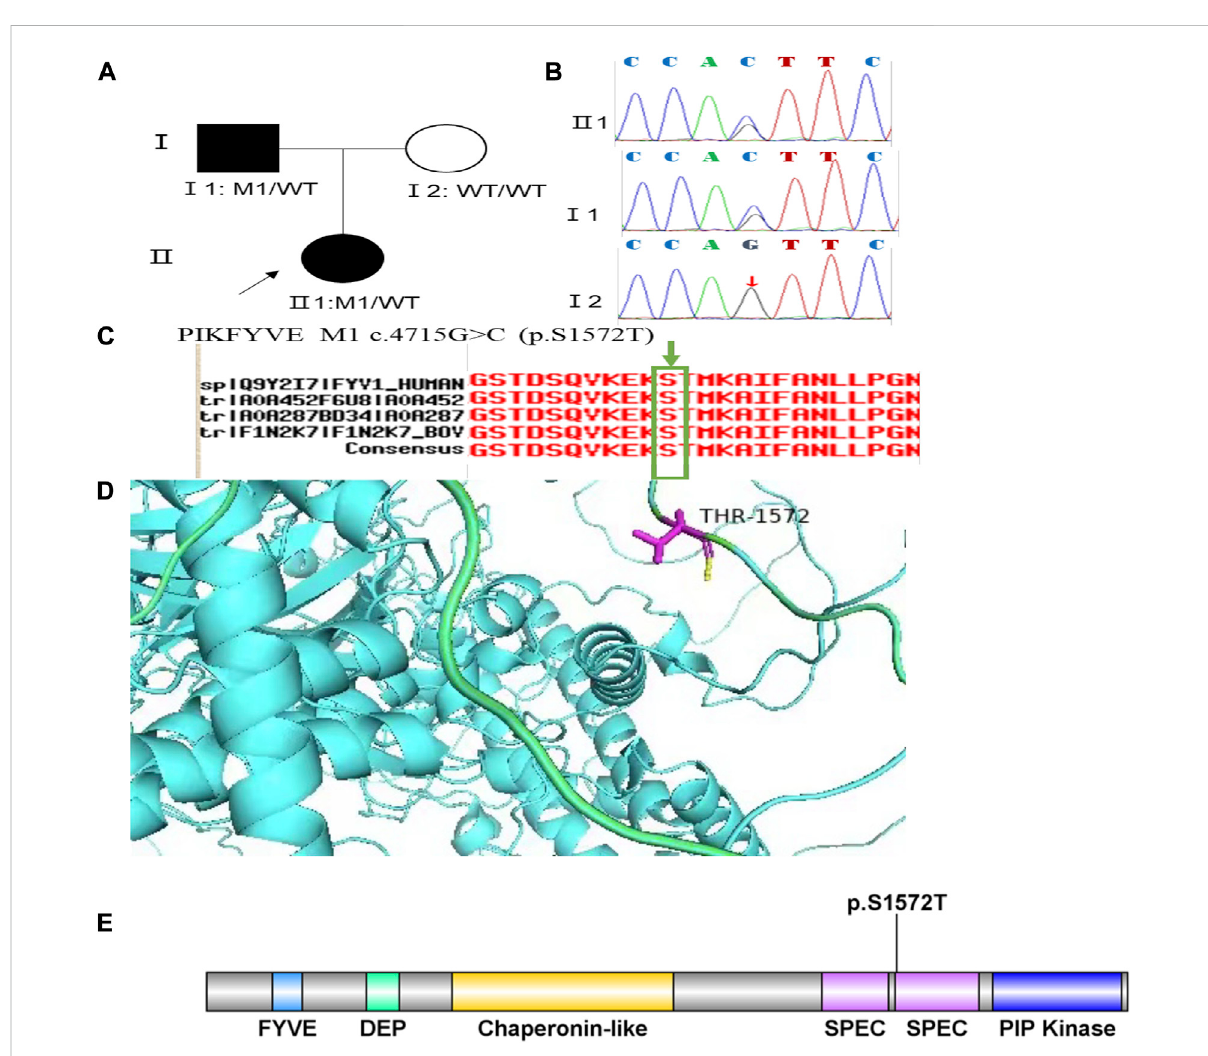
FIGURE 8 Sequenceanalysisandidenti fi cationofthenovelvariantofPIKFYVEintheaffectedChinesefamilywithautosomal-dominantKC. (A) Pedigreeof thefamily.The fi lledblacksymbolsrepresenttheaffectedmembers,andthearrowdenotestheproband. (B) Bysequencinganalysis,aheterozygous variant of (C) 4715G > C was identi fi ed in the affected individuals of II:1 and I:1. (C) The homology of amino acid sequences between human PIKFYVE and other species. The amino acid at position 1,572 (Serine, S1572) is highly conserved among species (green box). (D) Homology model of the 1-phosphatidylinositol 3-phosphate 5-kinase (green). Purple indicates the location of p. Ser1572Thr in the protein structure. (E) Structural modelling of 1-phosphatidylinositol 3-phosphate 5-kinase